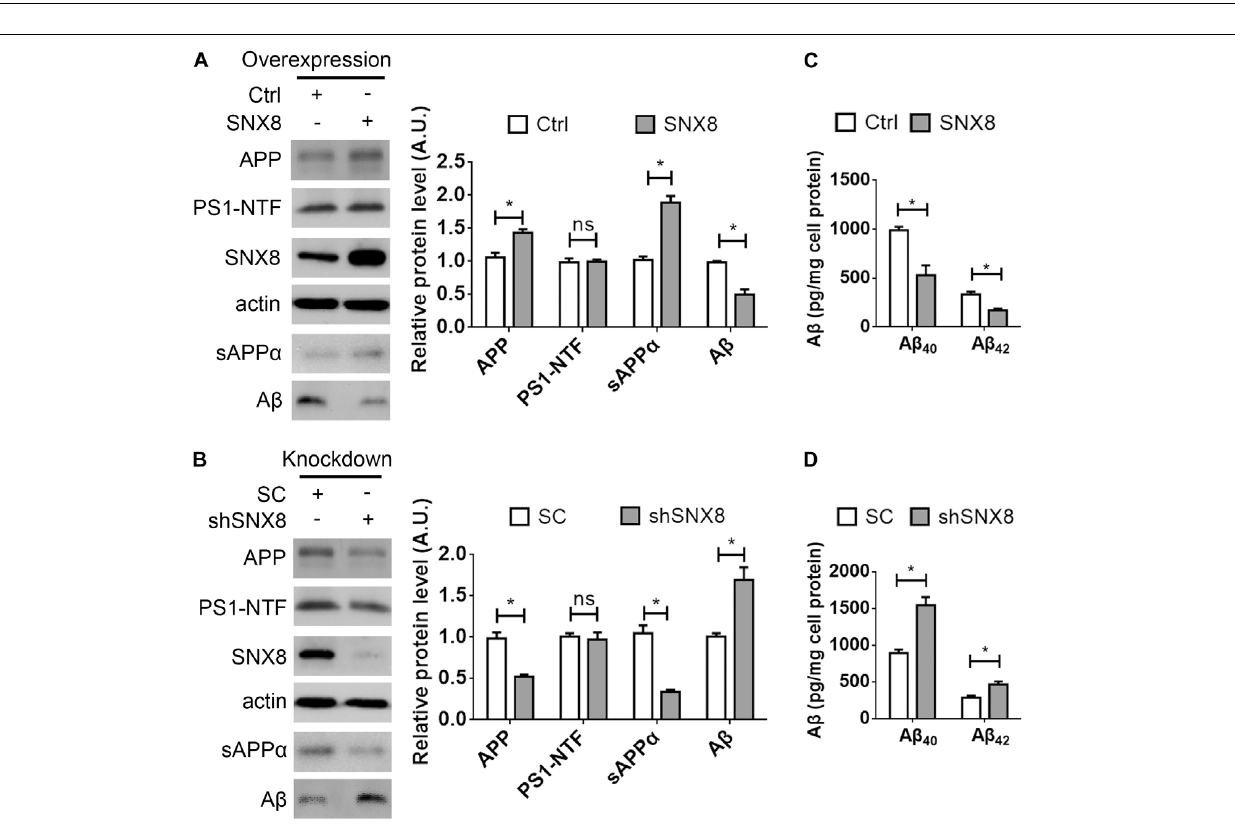
FIGURE 2 | Characterizing SNX8 Expression and Localization. (A) Human and mouse SNX8 protein sequences were aligned and compared. Conserved amino acid residues are highlighted in red/yellow, weak similarities are highlighted in green, and gaps are marked with dashed lines (“–”). (B) Equal protein quantities from various C57BL/6 mouse (2-month-old) tissues were analyzed for SNX8 and GAPDH. SNX8 band intensities were quantified by densitometry, normalized to GAPDH; and compared to levels detected in heart (set to 1.0), n = 3. (C) Equal protein quantities from cultured primary neurons, astrocytes and microglia were analyzed for SNX8, NeuN (neuron marker), Iba1 (microglia marker), GFAP (astrocyte marker), and β -actin levels. SNX8 levels were quantified by densitometry, normalized to those of β -actin, and then normalized to levels detected in neurons (set to 1.0), n = 4. (D) HeLa cells co-transfected with SNX8-myc and EGFP-tagged Rab4, Rab5, or Rab7 constructs were immunostained for myc (to detect SNX8, red) and stained with DAPI (blue). HeLa cells transfected with SNX8-myc were immunostained for myc (SNX8, red) and Giantin (green), and stained with DAPI (blue). Images were acquired by confocal microscopy. Rab4, Rab5, Rab7, and Giantin staining is depicted in green. Zoom images are magnified panels from regions in merged images. Scale bars, 10 µ m.